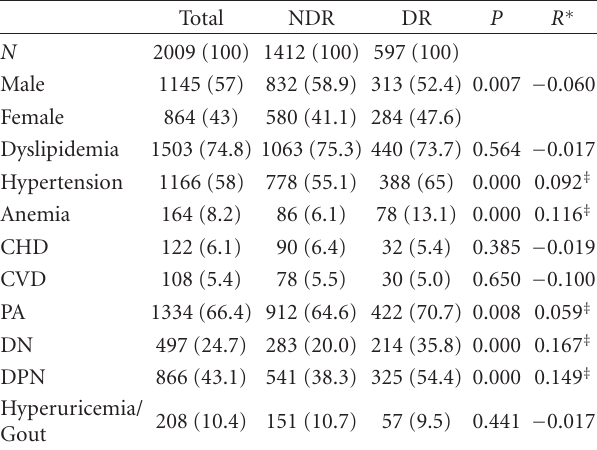
Table 1: Comparison of clinical characteristics and comorbidities among DR groups: N